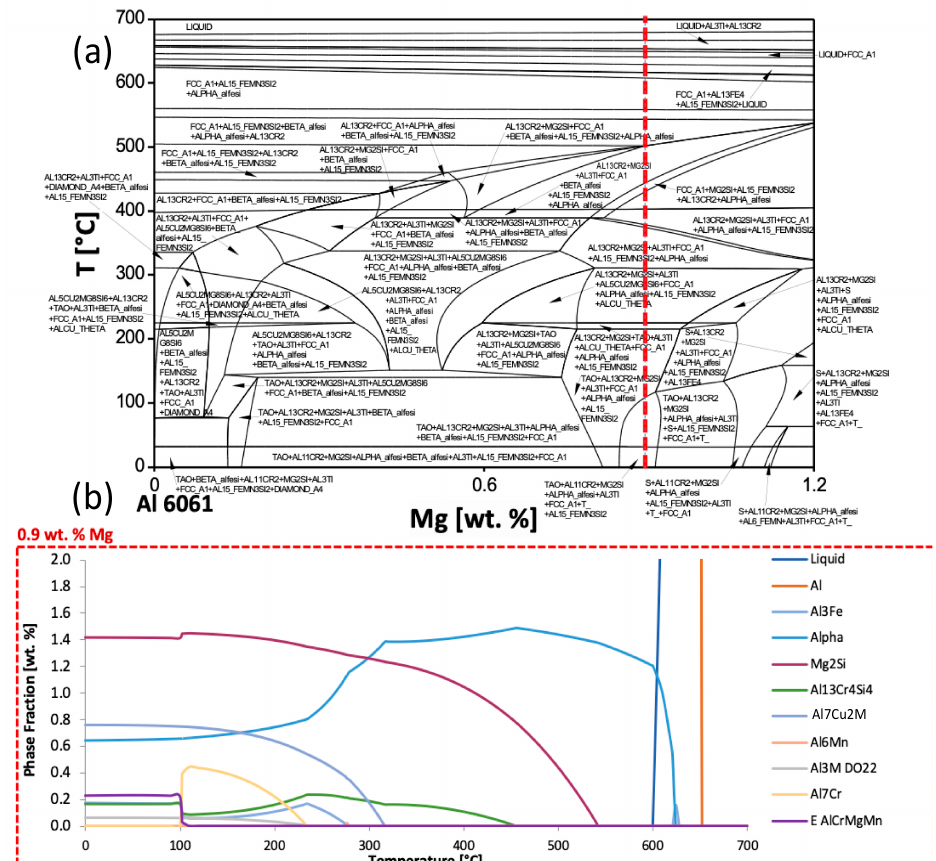
Figure 1. The temperature versus magnesium wt.% in the Al 6061 system considered is presented in ( a ) and represents an isopleth of the composition created using Pandat wherein each thermodynamically predicted equilibrium phase in the isopleth was labeled for emphasis and demonstrative purposes. The vertically dashed red line represents a magnesium wt.% of 0.9. From the isopleth in ( a ), the equilibrium phase fractions in Al 6061 at 0.9 wt.% magnesium as a function of temperature for the composition associated with the red line from ( a ) is presented in ( b ).